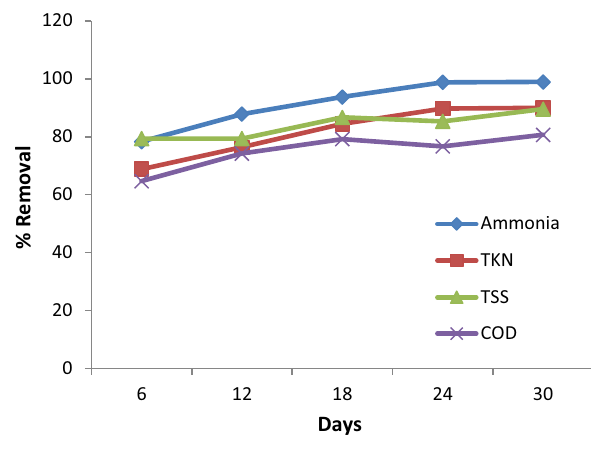
Fig. 3 Percentage reduction from the grit chamber after treatment in